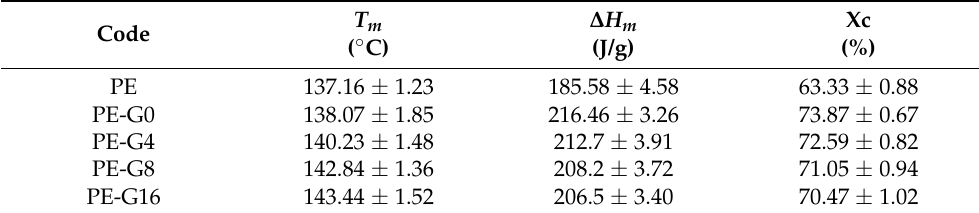
Table 3. DSC results.